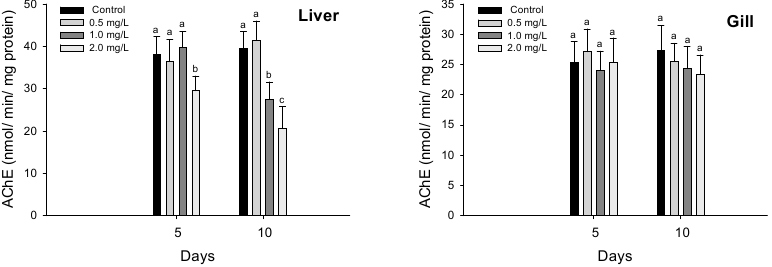
Figure 2. AChE inhibition of flatfish, Paralichthys olivaceus exposed to the different concentrations of waterborne chromium for 10 days. Values with different superscripts are significantly different in 5 and 10 days ( p < 0.05) as determined by Tukey’s multiple range test.